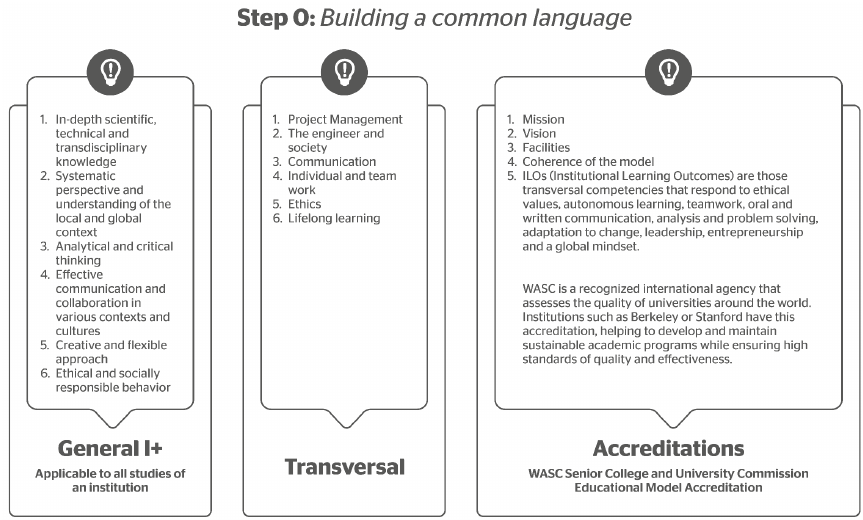
Fig. 3. Step 0: Building a common